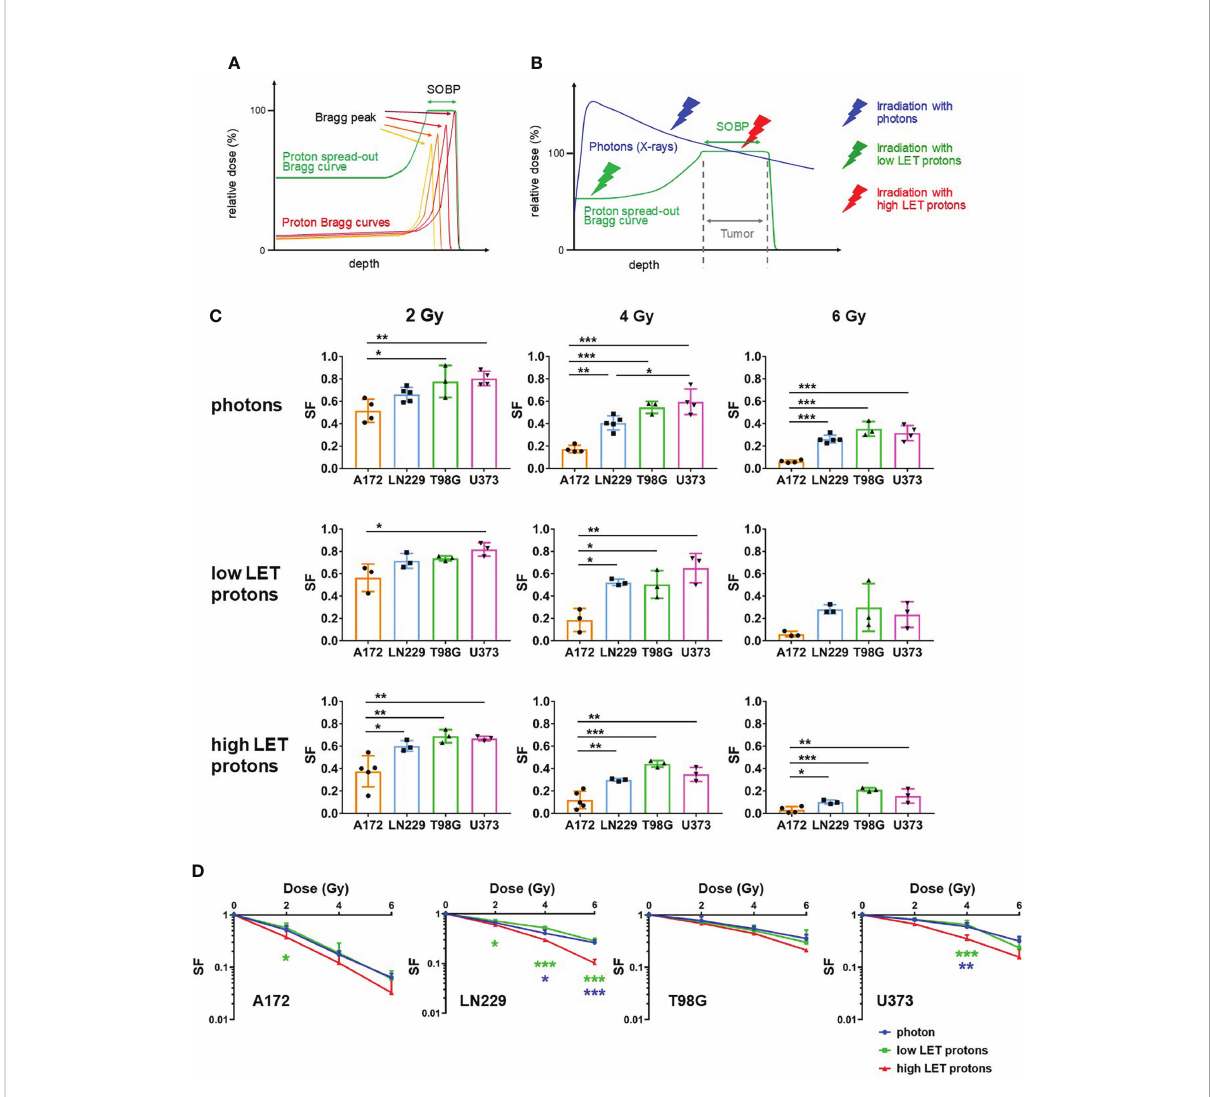
FIGURE 1 Irradiation with high LET protons reduced clonogenic survival more effectively than irradiation with photons or low LET protons. (A) Schematic presentation of a proton curve with spread out Bragg peak (SOBP) (green) built up of four proton beams with varying energies (low to high energy proton beams: dark red to orange). (B) Schema presenting dose deposition in tissue after irradiation with photons (blue) and protons (green). The thunderbolts indicate the region of the respective beams used to irradiate glioblastoma cells (blue: photons/X-rays; green: low LET protons; red: high LET protons). (C, D) Glioblastoma cells (A172, LN229, T98G and U373) were irradiated with respective beams at 0 Gy, 2 Gy, 4 Gy and 6 Gy and incubated to allow formation of colonies. Surviving fractions were calculated by determining the quotient of counted colonies to plated cells and subsequent normalization to the respective quotient for non-irradiated cells. (C) Surviving fraction (SF) of different cell lines was compared after irradiation with respective beams at 2 Gy (left panels), 4 Gy (middle panels) and 6 Gy (right panels). (D) The effect of the different beams (blue: irradiation with photons; green: irradiation with low LET protons; red: irradiation with high LET protons) on survival fraction was compared. N ≥ 3. *p < 0.05; **p < 0.01; ***p < 0.001 (blue: signi fi cance between irradiation with photons and high LET protons; green: signi fi cance between irradiation with low LET protons and high LET